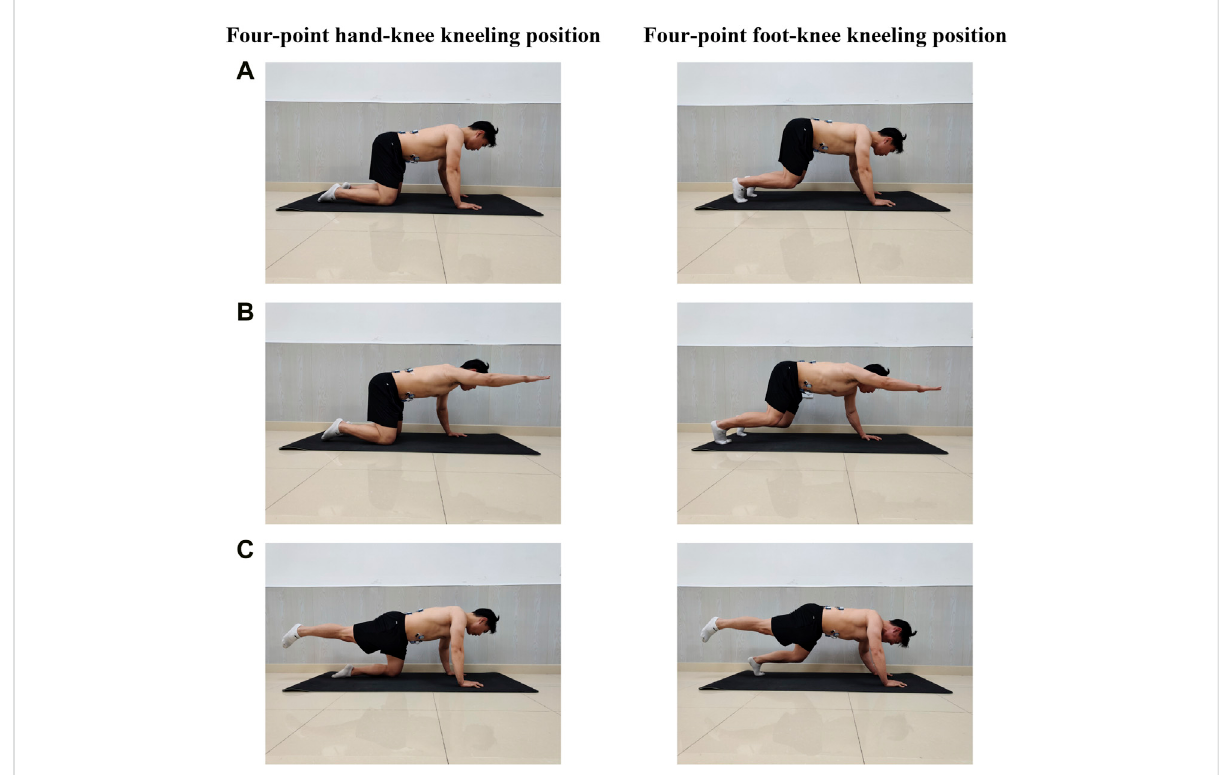
FIGURE 1 Corestabilizationexercises intwopositions. (A) Exercisesinthestarting position. (B) Exerciserswithasingleupperlimblifted; participants lifted their right or left upper limb parallel to the fl oor, respectively. (C) Exercisers with a single lower limb lifted; participants lifted their right or left lower limb parallel to the fl oor as possible,